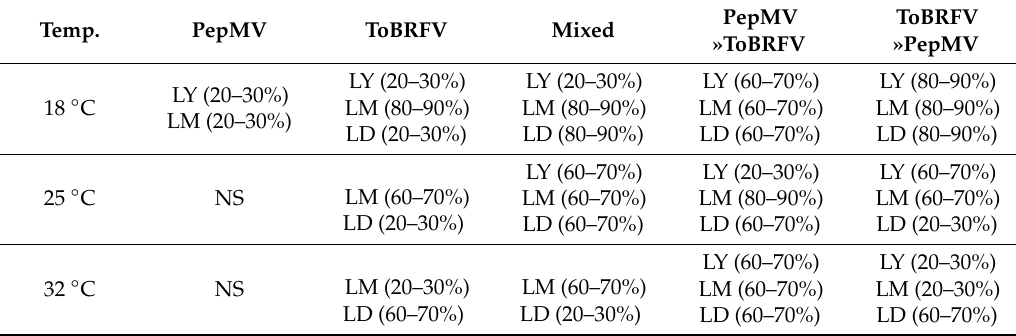
Table 3. Symptom manifestations in mixed-infected tomato plants inoculated with a mixture of tomato brown rugose fruit virus (ToBRFV) and pepino mosaic virus (PepMV) or sequentially by pre-inoculations with PepMV or